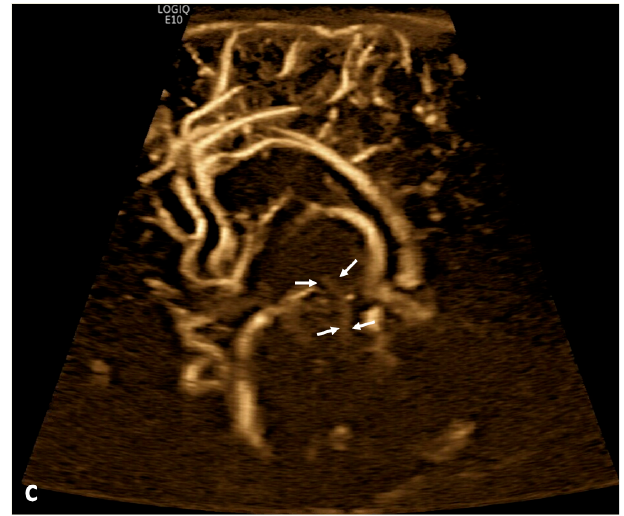
Figure 1. Cerebrospinal fluid (CSF) flow visualized in the ventricular system. A 15-day-old term girl with a history of bilateral grade III intraventricular hemorrhage and hydrocephalus underwent brain ultrasound. This patient also had cardiovascular comorbidities, including dextro-transposition of great arteries, ventricular septal defect, and tricuspid regurgitation. ( a – c ) Sagittal B-Flow demonstrates turbulent caudocranial CSF flow in the cerebral aqueduct (arrows). The entire clip is provided as Supplemental Material S1.